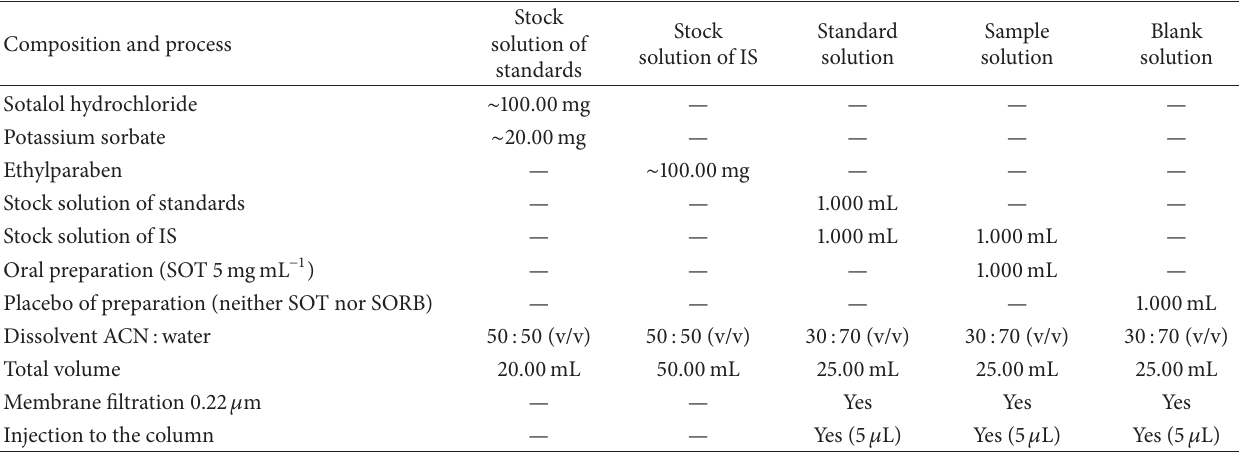
Table 2: Stock, IS, standard, sample, and blank solutions preparation.